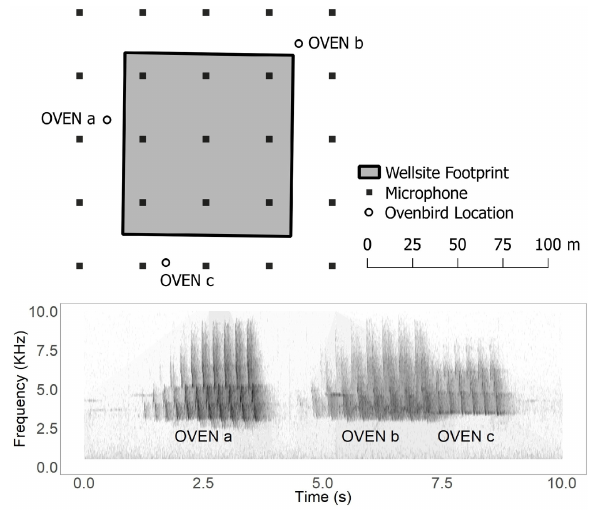
Fig. 1 . Example countersinging event, where singing events of three Ovenbirds ( Seiurus aurocapilla ) occurred greater than 37.2 m apart during the 25.5 s interval. The labelled vocalizations in the spectrogram that was from the microphone in the center of the wellsite correspond with the labelled spatial locations over the wellsite. Sites varied slightly in microphone spacing and